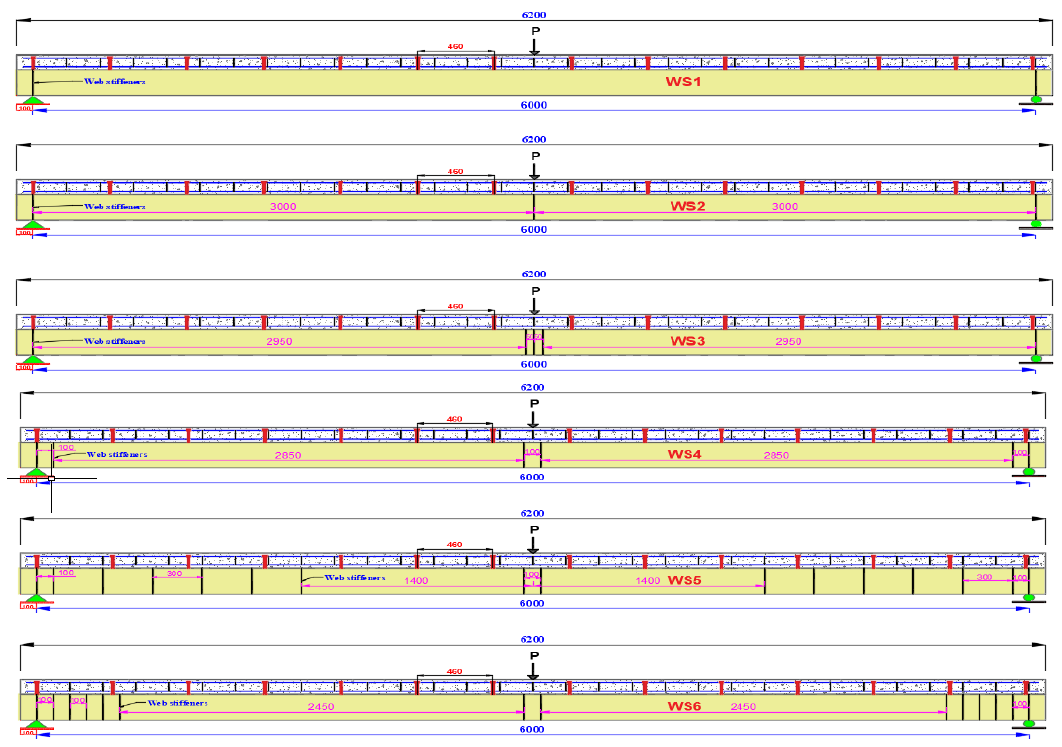
Figure 9. Geometry and dimensions of the curved composite beam with web stiffeners (unit: